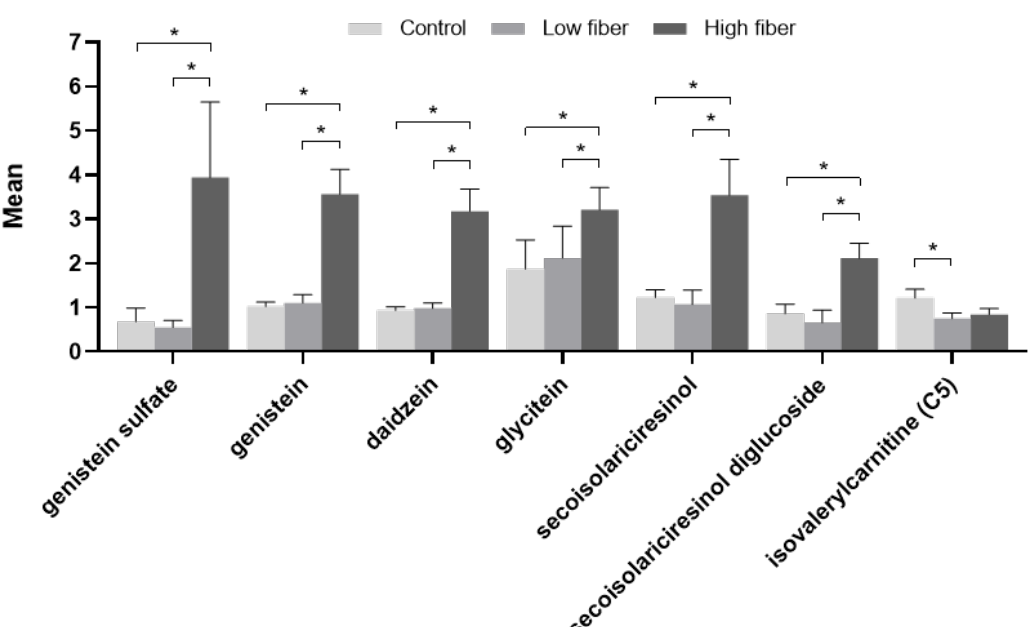
Figure 3. Fecal metabolites from dogs with early renal disease fed the control, low soluble fiber plus betaine, and high soluble fiber plus betaine foods. Data were analyzed via a linear mixed model with animal ID as a random variable, were rescaled to a median value of 1, and are presented as group means and standard errors. * p ≤ 0.05.